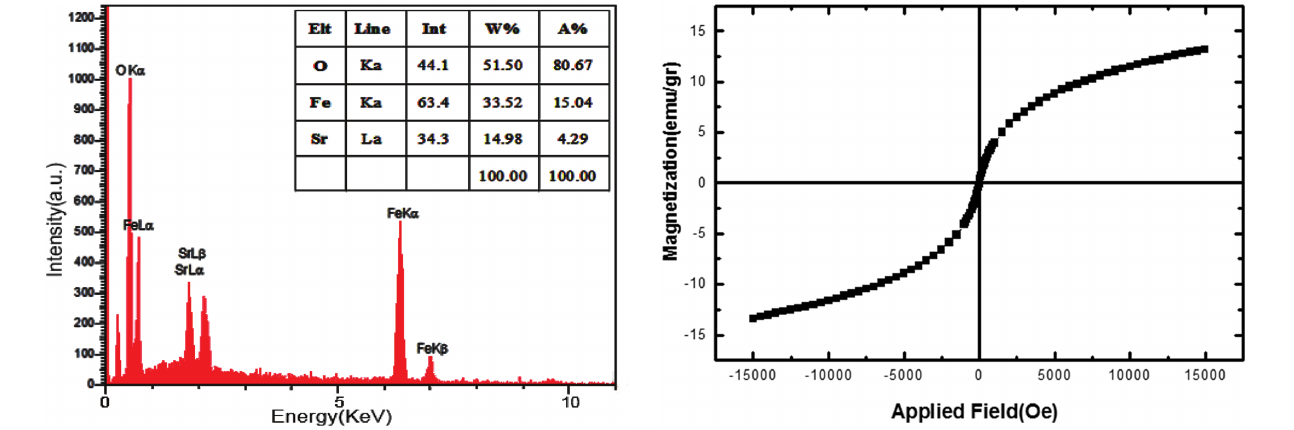
Figure 16: VSM of SrFe